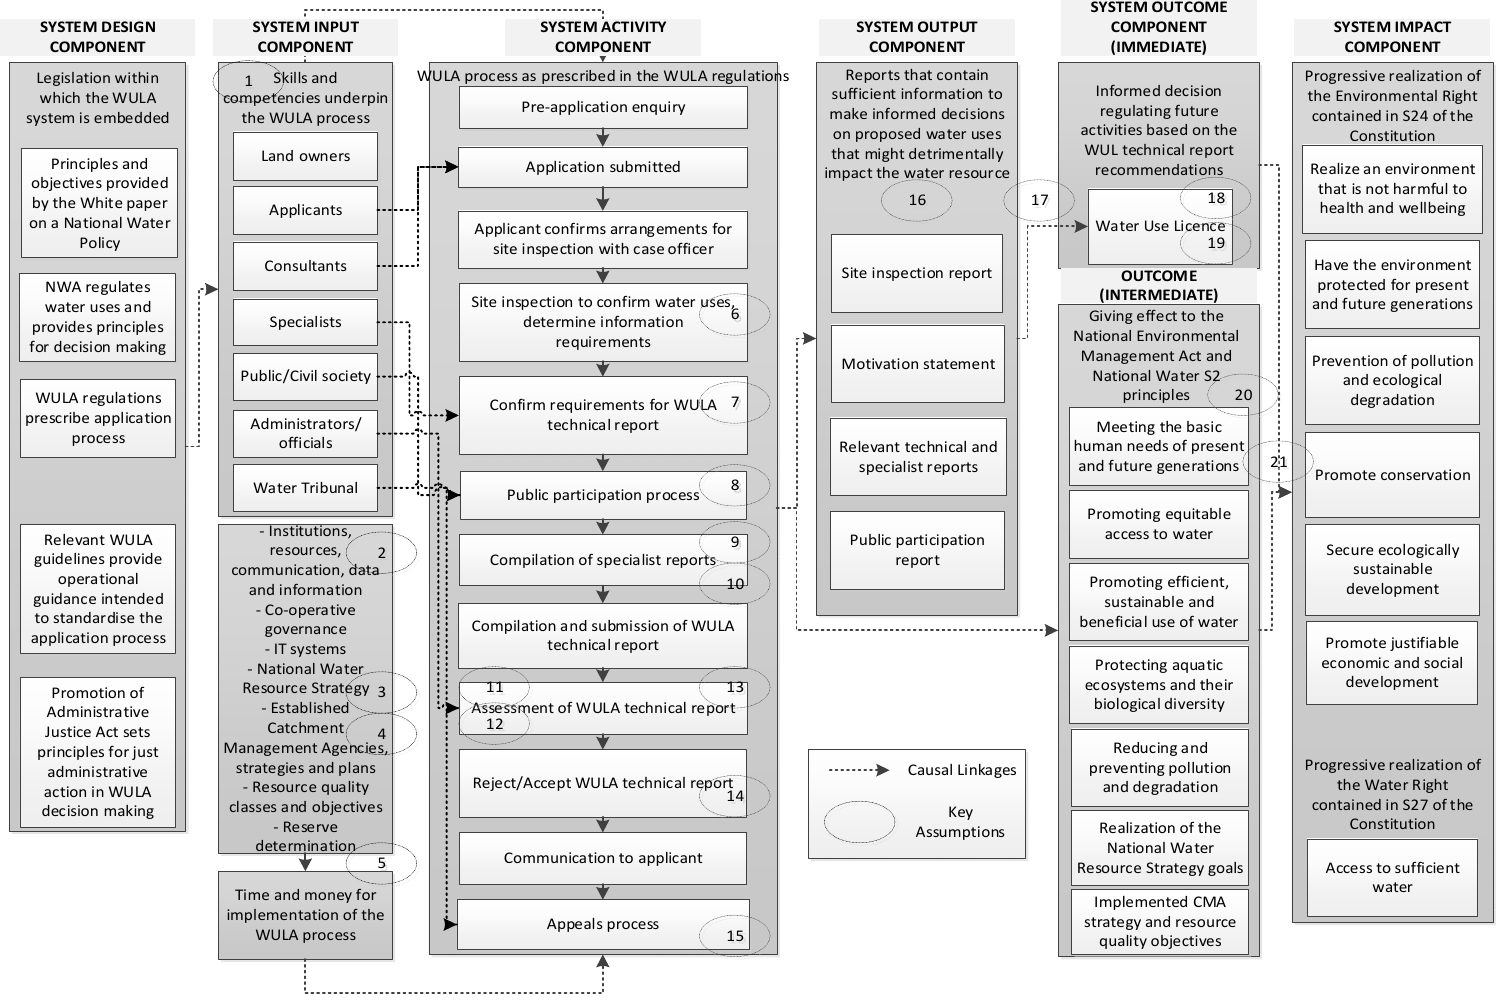
Figure 2. ToC map of the South African WULA system.